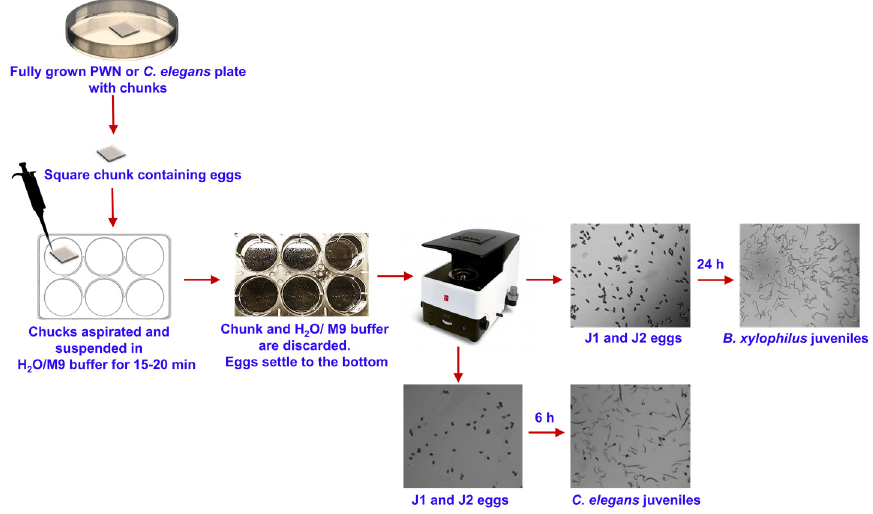
Figure 2. Pictorial representation of technique used to isolate nematode eggs and juveniles from small chunks of B. cinerea lawns on PDA agar or Escherichia coli OP50 lawns on nematode growth medium (NGM)